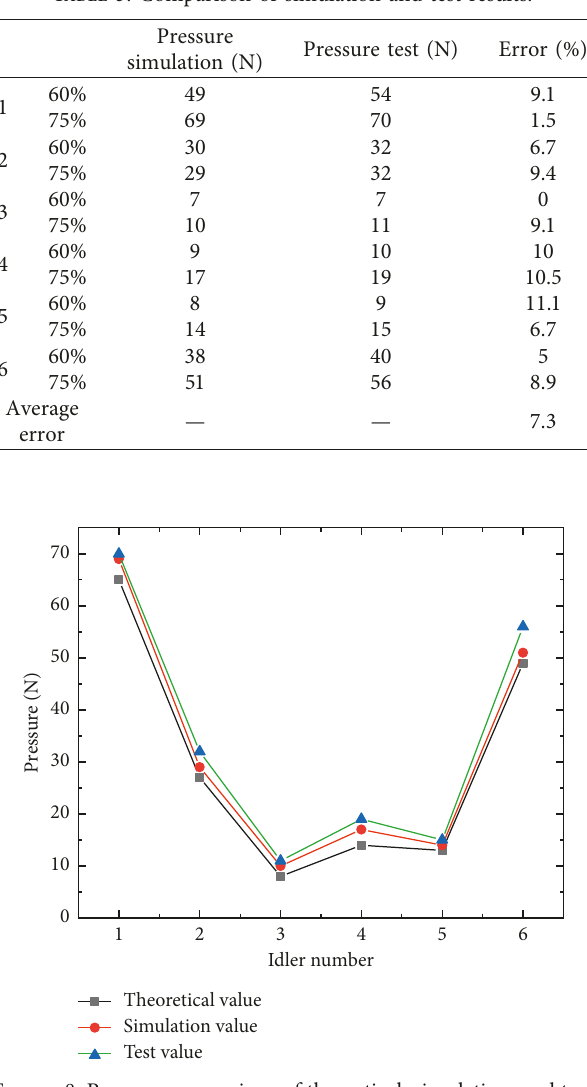
Table 3: Comparison of simulation and test results.